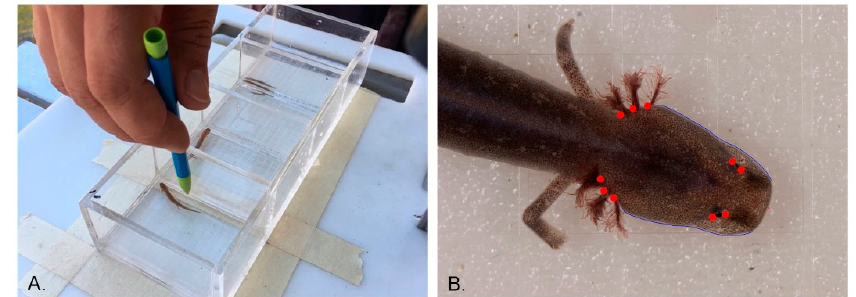
Figure 1. ( A ) Acrylic chambers for salamander photography on site at Eliza Spring, with 5 mm background grids for measurement calibration; ( B ) Landmark configuration used for geometric morphometrics analyses of head shape. Red symbols represent fixed landmarks and the blue lines represent sliding semi-landmarks (15 equidistant landmarks for each side of the head).